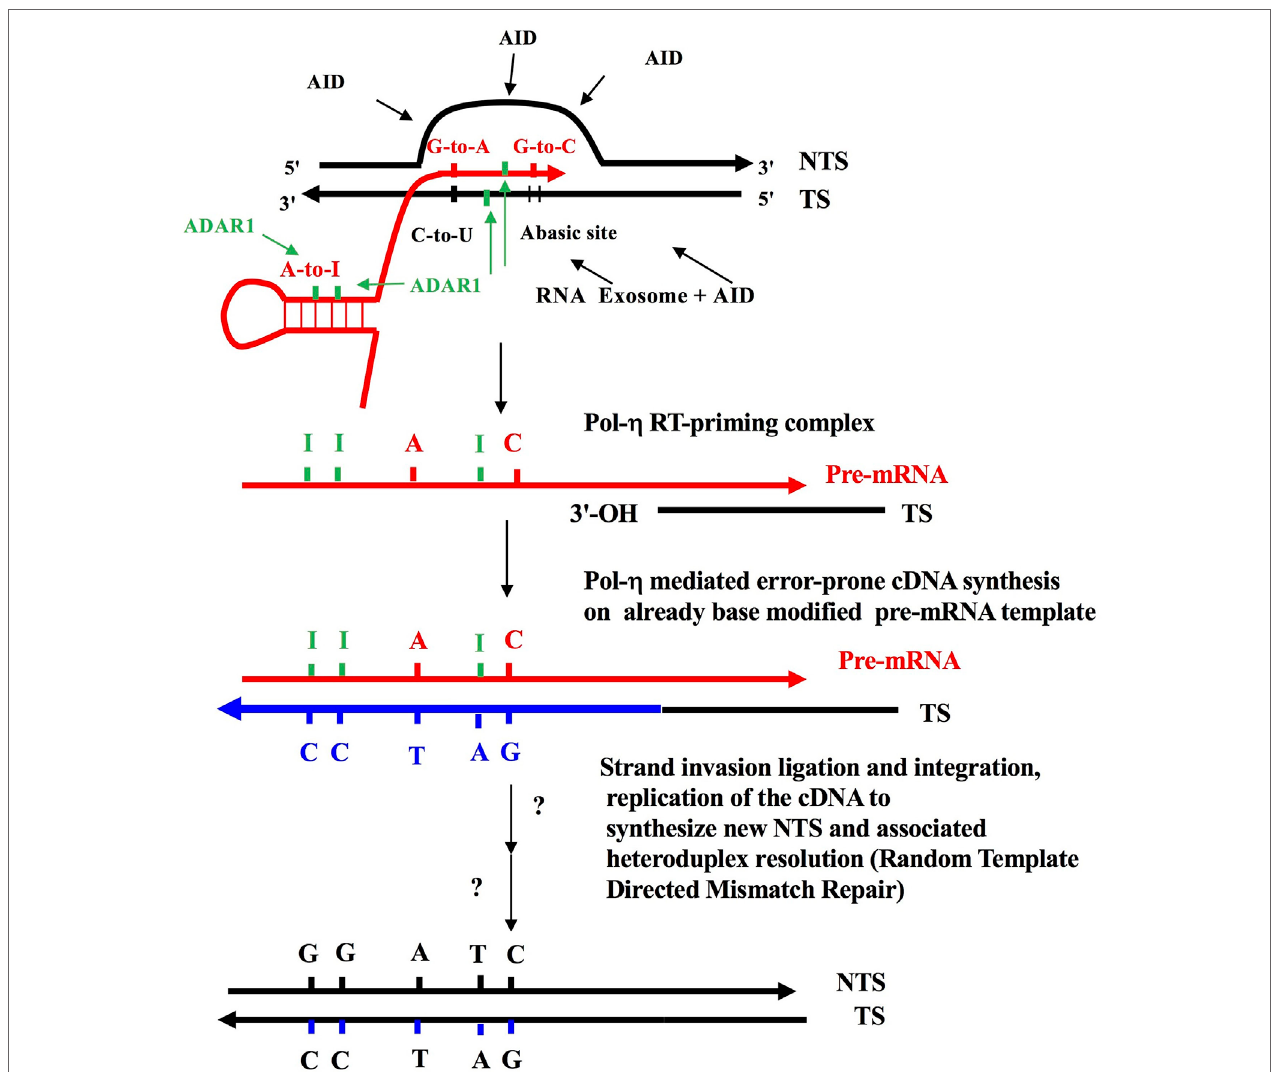
FiGUre 1 | The reverse transcriptase mechanism of somatic hypermutation (SHM). Some elements of this figure have appeared before, and this figure in toto is a modified combination of parts from Figure 1 in Lindley and Steele (10), as well as from figures in Steele (9, 11) and Steele and Lindley (14). This is also an adaptation of the target site reverse transcription process of Luan et al. (66). Shown is an RNA Polymerase II-generated Transcription Bubble with C-site and A-site substrate deamination events by AID and ADAR proteins, which generates the strand-biased mutation signatures—A-to-G, G-to-A, G-to-T, and G-to-C (9, 11, 14). DNA strands shown by black lines; pre-mRNA as red lines; cDNA strands as thick blue lines due to DNA polymerase η (59). Green bars are Inosines. Shown also is the action of the RNA exosome (64) allowing access of AID deaminase to cytosines on the transcribed strand (TS). The ssDNA regions on the displaced non-transcribed strand (NTS) are established targets of AID action (53–56). Note that DNA mutations are first introduced as AID-mediated C-to-U, followed by excision of uracils by DNA glycosylase (UNG), which creates Abasic sites in the TS (these can mature into single strand nicks with 3 ′ -OH ends via the action of AP endonuclease). These template Uracil and Abasic sites can be copied into pre-mRNA by RNA Pol II generating G-to-A and G-to-C modifications as shown (67). Following target site reverse transcription (66), this results in G-to-A and G-to-C mutations in the NTS, in a strand biased manner (9–11, 14). Separately at WA targets in nascent dsRNA substrates, adenosine-to-inosine (A-to-I) RNA editing events, mediated by ADAR1 deaminase, are copied back into DNA by reverse transcription via Pol- η (59). In theory, ADARs can also deaminate the RNA and DNA moieties in the RNA: DNA hybrid (14, 15). The strand invasion and integration of newly synthesized cDNA TS, as well as random-template mismatch repair (68) are hypothesized additional steps (not shown here). In short, RNA Pol II introduces modifications in the Ig pre-mRNA as it copies TS DNA with AID lesions and this is coupled to A-to-I in dsRNA stem-loops near the transcription bubble (62) as well as in RNA:DNA hybrids within the bubble (14, 15). Next, a RT-priming substrate is formed when the nicked TS strand with an exposed 3 ′ -OH end anneals with the base modified pre-mRNA copying template allowing cDNA synthesis by Y Family translesion DNA polymerase- η (48), now acting in its reverse transcriptase mode (59). These 3 ′ -OH annealed priming sites could arise due to excisions at previous AID-mediated Abasic sites. Alternatively, they could arise due to an endonuclease excision associated with the MSH2-MSH6 heterodimer engaging a U:G mispaired lesion (61). Shown is an A-to-T transversion generated at the RT step at a template Inosine. ADAR, Adenosine Deaminase that acts on RNA; AP, an Abasic, or apurinic/apyrimidinic, site; APOBEC family, generic abbreviation for the dC-to-dU deaminase family of which AID is a member (e.g., APOBEC1; APOBEC3 A, B, C, D, F, G, H); AID, activation induced cytidine deaminase causing C-to-U lesions at WRCY/RGYW C-site motifs in ssDNA; W, A, or U/T; WA-site, target motif for ADAR deaminase including DNA polymerase- η error prone incorporation in vitro (50, 51); Y, pyrimidines T/U or C.; R, purine A or